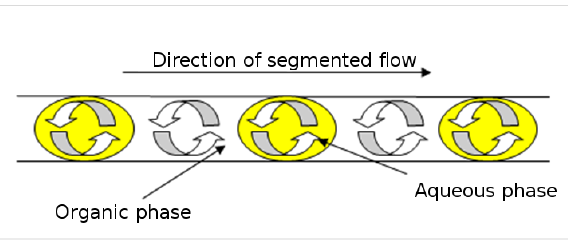
Figure 9: Schematic illustrating the mixing of immiscible reagent streams in a microfluidic channel, whereby the continuous phase com- position depends on the ratio of organic and aqueous reactants employed.